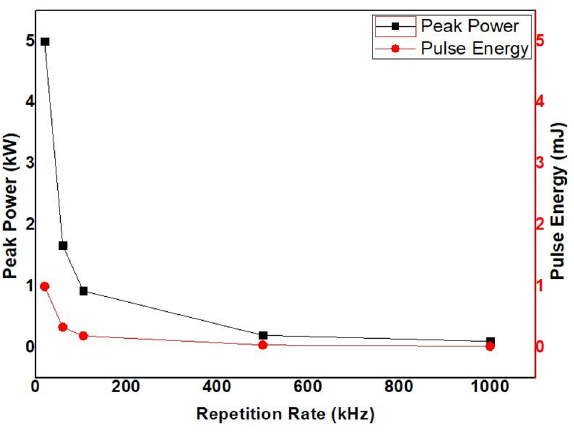
Figure 24. Pulse Energy and Peak Power versus Repetition